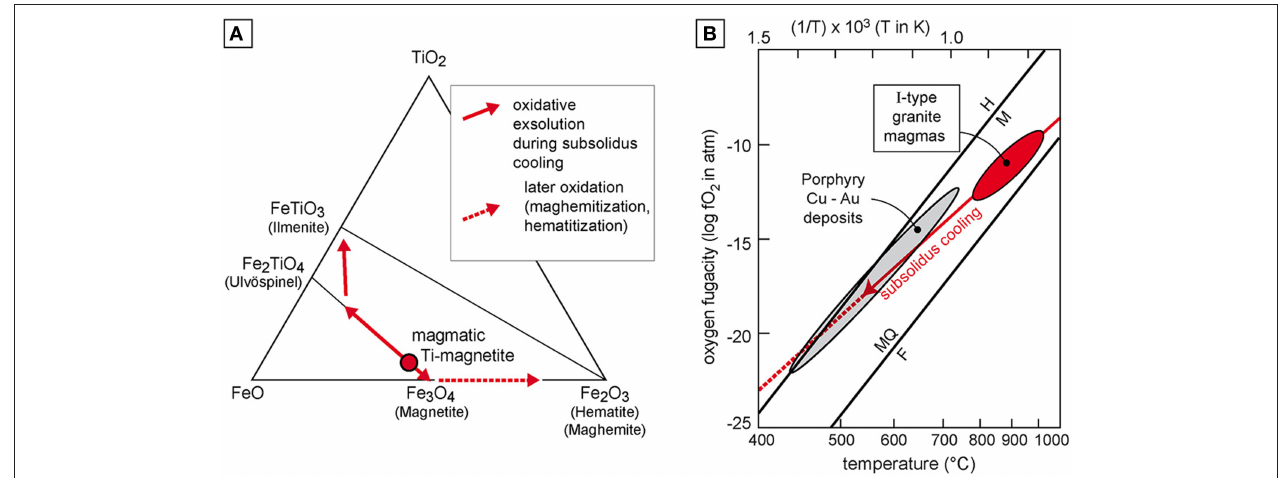
FIGURE 1 | (A) Solid solution series of Fe-Ti oxides; arrows indicate the subsolidus evolution of a magmatic titanomagnetite. (B) (fO 2 , T) diagram showing the usual conditions of I-type granitic magmas and related porphyry Cu-Au deposits with respect to the FMQ (fayalite-magnetite-quartz) and H-M (hematite-magnetite) buffers, modified after Richards